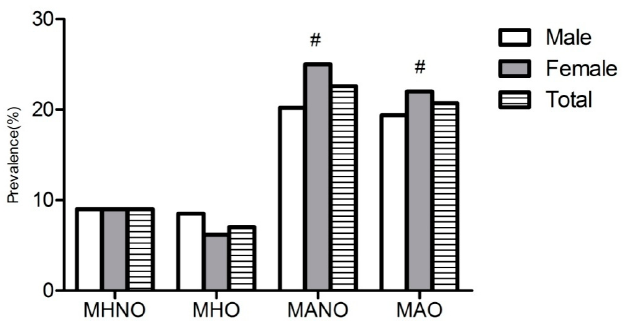
Figure 4. Prevalence of mild reduced eGFR among males and females in different obese phenotypes. # means compared with males, females have significantly higher prevalence of mild reduced eGFR.